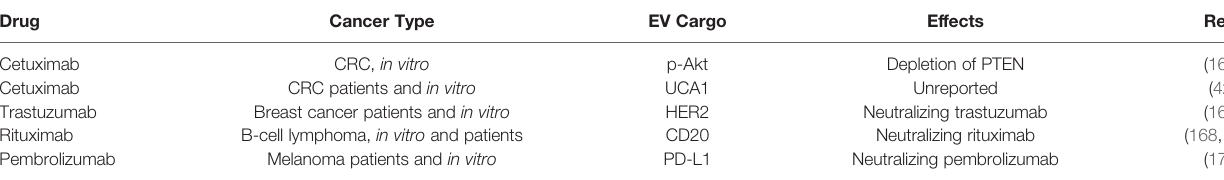
TABLE 5 | Resistance to biological drugs mediated by EVS.